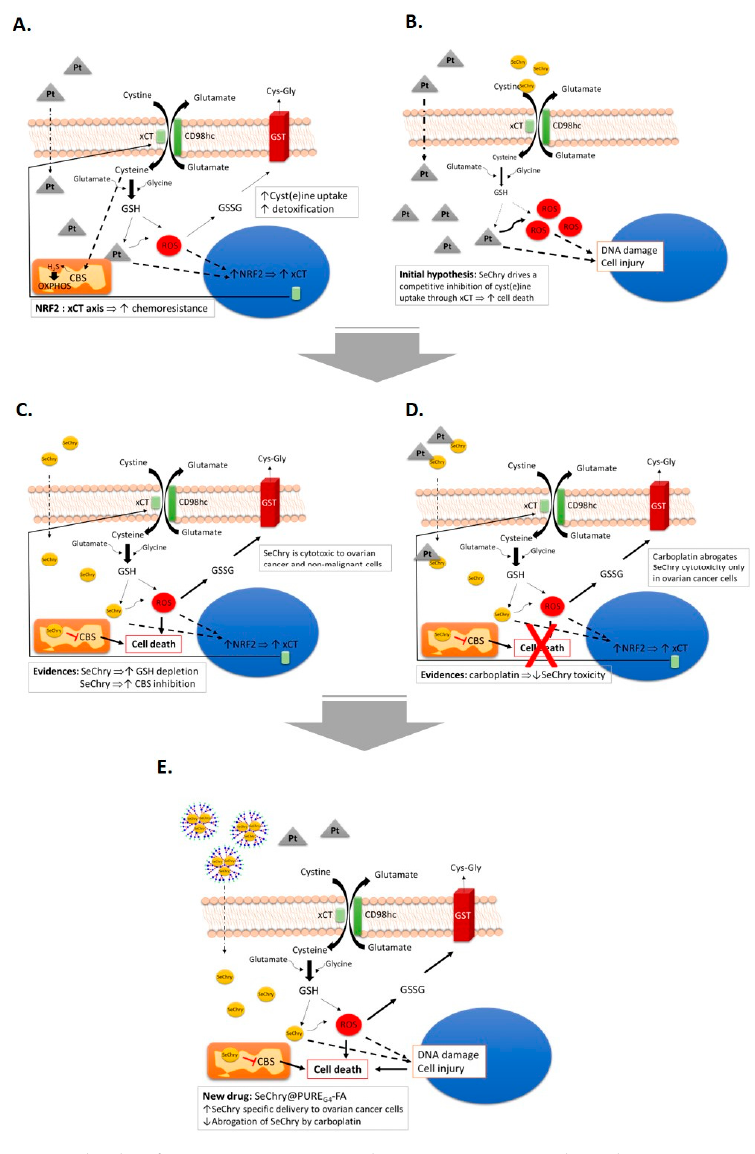
Figure 7. The central role of xCT transporter in chemoresistance and SeChry@PURE G4 -FA as a new drug to treat ovarian cancer. ( A ) Putative e ff ects of cyst(e)ine (cystine and cysteine) in platinum salt chemoresistance (carboplatin) by contributing to the bioavailability of glutathione (GSH), detoxifying drugs, andreactiveoxygenspecies(ROS),contributingalsototheproductionofH 2 S,supplyingoxidative phosphorylation (OXPHOS). Oxidized GSH (GSSG) is exported through the action of glutathione transferase (GST) Exposure to carboplatin, putatively, activates xCT / SLC7A11 transcription under the action of Nrf2. ( B ) We hypothesized that, by disturbing cyst(e)ine metabolic flux, chemoresistance would be reverted. Since the xCT transporter is also responsible for selenium uptake, we chose to test selenium-containing chrysin (SeChry) as a competitive inhibitor of xCT. ( C ) SeChry revealed to be toxic to ovarian cancer and non-malignant cells, albeit without impairing cyst(e)ine uptake. On the contrary, it increased GSH turnover and also inhibited cystathionine β -synthase (CBS), an H 2 S producing enzyme. ( D ) The cytotoxic e ff ect of SeChry was abrogated by carboplatin in ovarian cancer cells, but not in non-malignant cells, probably due to the chemical interaction between the two compounds. ( E ) The selective delivery of SeChry encapsulated in a folate-targeted polyurea dendrimer nanoparticle (SeChry@PURE G4 -FA) presents higher cytotoxicity to ovarian cancer cells compared to non-malignant cells and avoids SeChry inactivation by carboplatin. We propose SeChry@PURE G4 -FA as a new drug formulation to treat ovarian